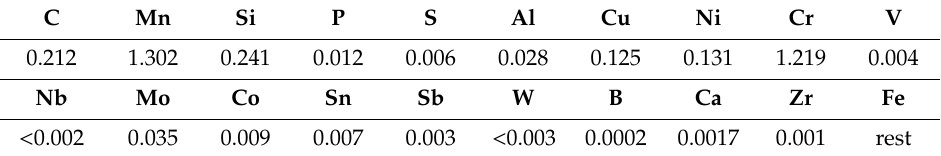
Table 1. Chemical composition (wt.%) of 16MnCr5 grade steel reference material.